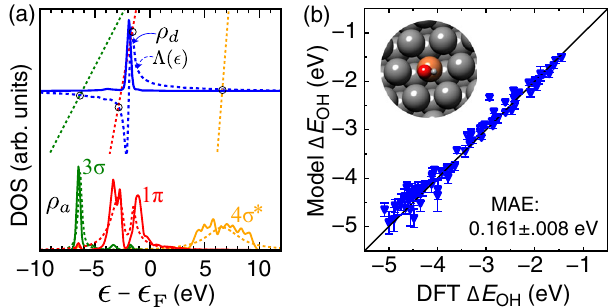
Fig. 3 Out-of-sample validation of the TinNet model. a Projected density of states ρ a onto the OH 3 σ , 1 π , and 4 σ * orbitals from DFT calculations (solid) and TinNet models (dashed), taking Cu 1 /Ag(111) as an example (Ag: dark gray, Cu: brown). The graphical solution to the Newns – Anderson model is also shown, in which the intersections of the adsorbate line y ¼ ð ϵ (cid:2) ϵ Þ = πβ V 2 Λ ( ϵ ) of the a ad for each orbital with the Hilbert transform density of d -states ρ d represent the adsorbate – substrate bonding and antibonding states (2 localized roots) for 1 π and the resonance state (1 localized root) for 3 σ and 4 σ * . b DFT-calculated vs. TinNet-predicted *OH adsorption energies for out-of-sample single-atom alloys. A broad range of transition-metal atoms (26 in total) were used as the single-site substitute of the coinage metal host, i.e., Cu, Ag, and Au. The error bar corresponds to the standard deviation of the error estimates from 10 fi nal